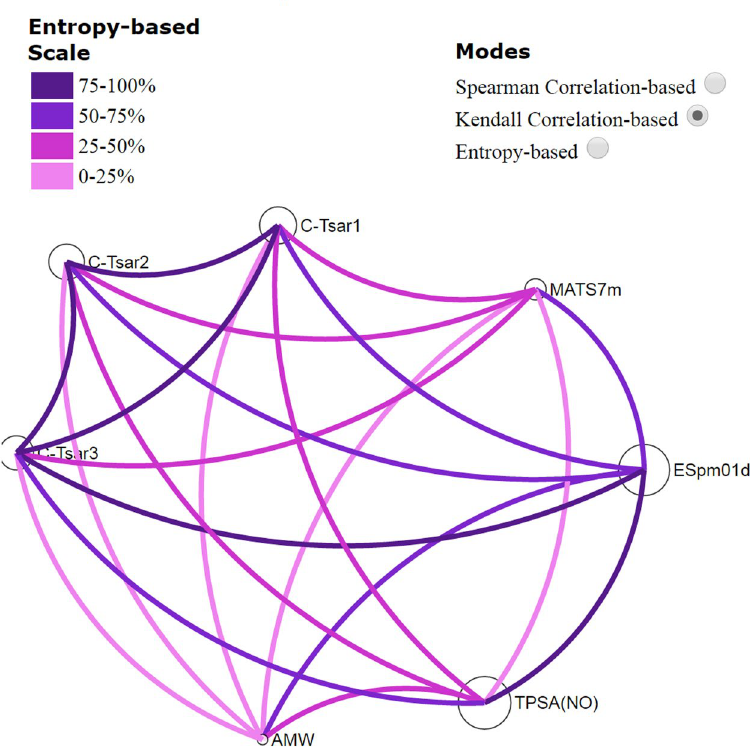
Figure 5. Mutual information analysis among the molecular descriptors that conform the M5 HIA ∪ CT HIA